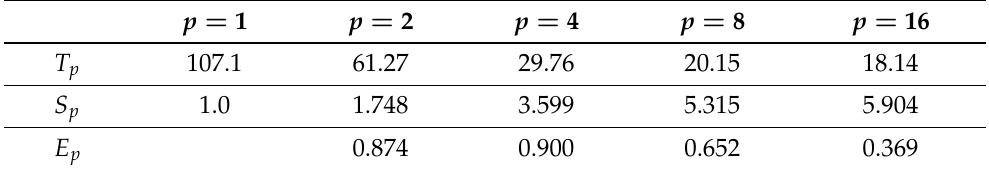
Table 6. The AAA algorithm (19): the values of the speedup S p and efficiency E p numbers for α = 0.5 and different numbers of cores. The order of the AAA algorithm is fixed to m = 5.